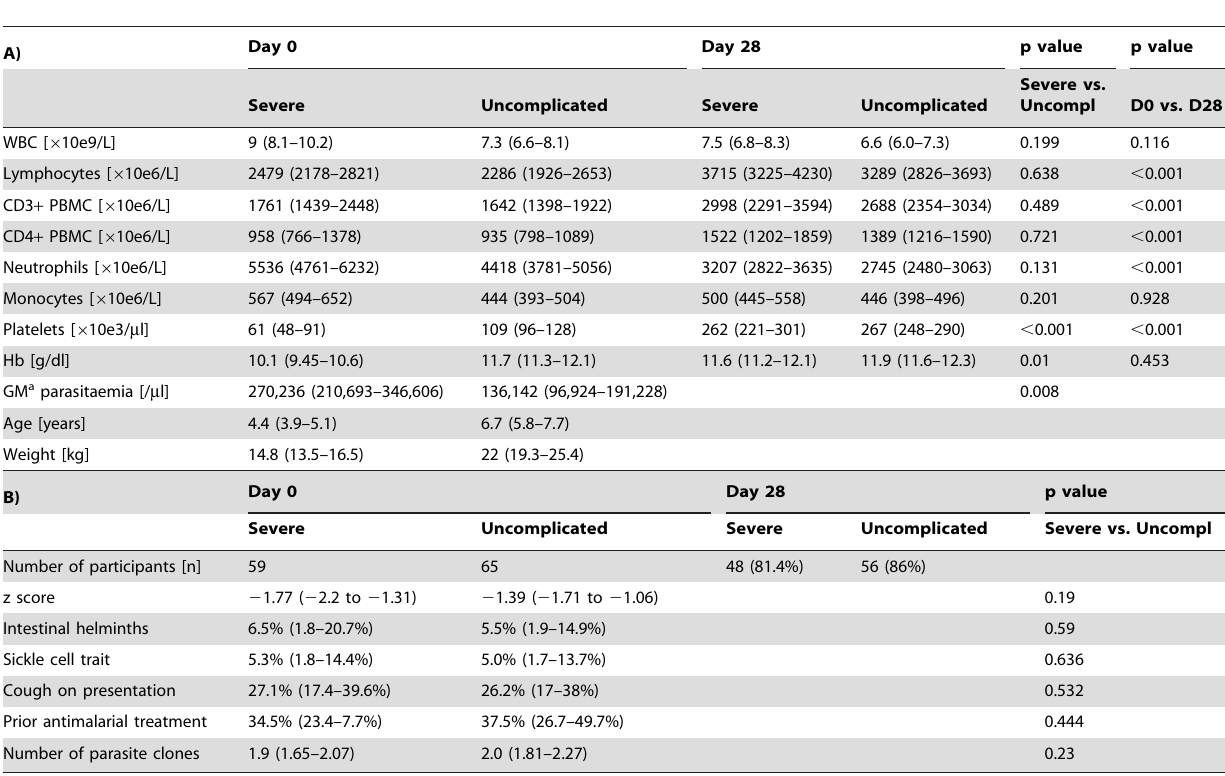
Table 1. Characteristics of study participants (A) and distribution of potential confounding factors